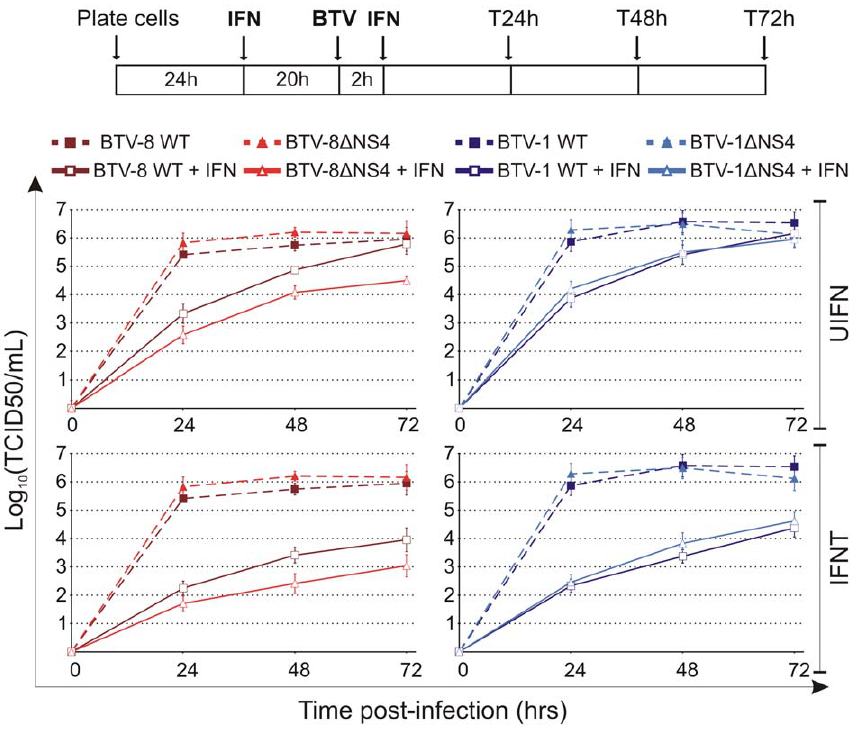
Figure 7. Invitro growth properties of rescued WT and D NS4 viruses during interferon treatment. CPT-Tert cells were treated (solid line) or mock treated (dashed line) with 1000 AVU/ml of interferon ( Tau, IFNT or Universal, UIFN) for 20 h prior and 2 h after being infected by BTV-8 (dark red, square), BTV8- D NS4 (red, triangle), BTV-1 (blue, square) and BTV1- D NS4 (light blue, triangle) viruses. Cells were infected at a MOI of 0.01. Supernatants were collected at 24, 48 and 72 h after infection, and then titrated on BSR cells by limiting dilution analysis and virus titers expressed as log 10 (TCID 50 /ml). In parallel, each virus preparation was also re-titrated by limiting dilution analysis to control that equal amounts of input virus was used in each experiment. This experiment was performed three times, each time in